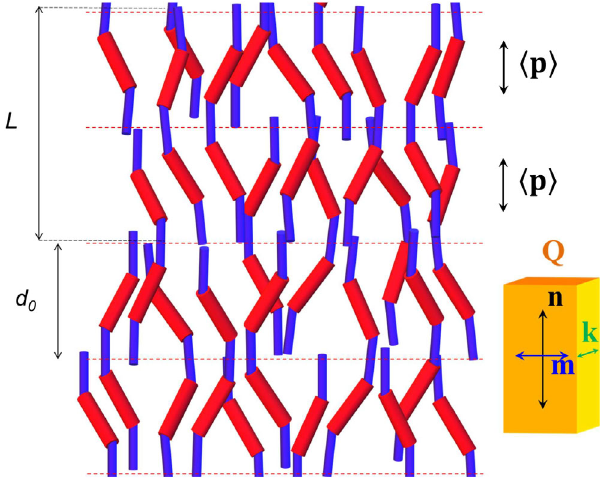
ð Sm A Þ structure. 25. Sketch of an M phase with a Sm A X b b ð Sm C Þ structure presented in Fig. 3, the As for the Sm A b A monomer units form smectic liquid layers with thickness d 0 ≈ L= 2 . The dimers span again two adjacent layers and form an orthogonal intercalated smectic phase with biaxial orienta- tional order parameter tensor Q . However, in each layer, the average orientation of the monomer axis p is parallel to the layers normal, because the tilt of the monomers is doubly degenerated, which is quite unlikely due to a strong energetic